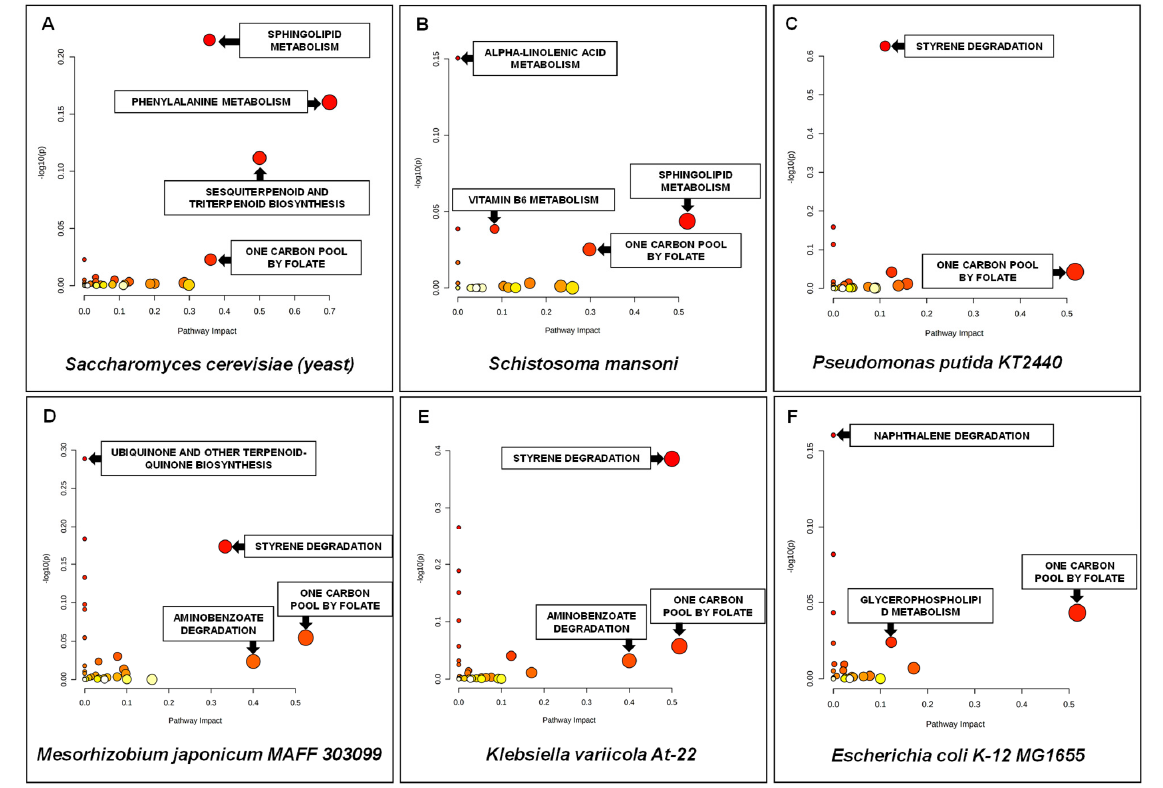
Figure 16. Summary of pathway analysis for soil samples. All the matched pathways are displayed as circles. The colour and size of each circle are based on the p -value and pathway impact value. Metabolites from: ( A ) Saccharomyces cerevisiae ; ( B ) Schistosoma mansoni ; ( C ) Pseudomonas putida ; KT2440; ( D ) Mesorhizobium japonicum MAFF 303099; ( E ) Klebsiella variicola At-22; ( F ) Escherichia coli K-12 MG1655.